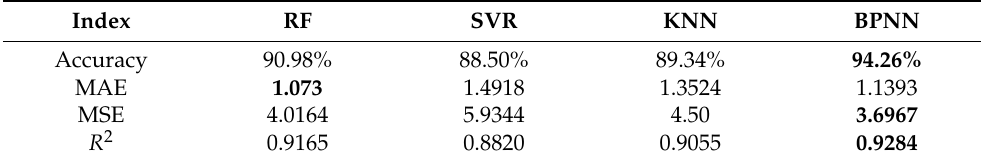
Table 3. Comparison of evaluation indexes of four evaluation